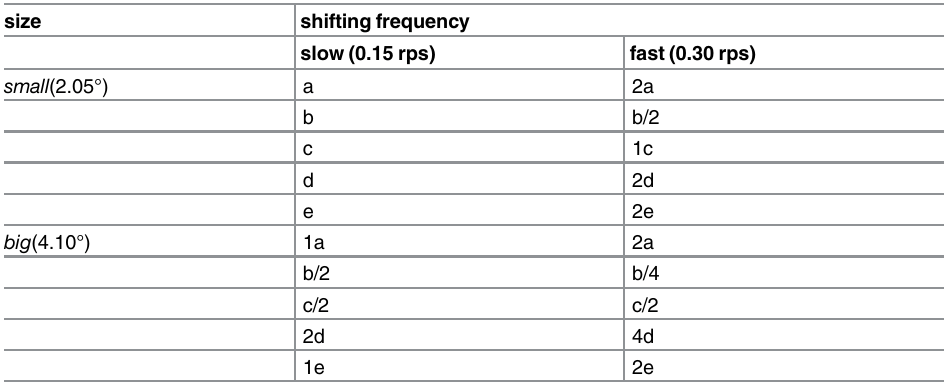
Table 1. Experimental Manipulations.